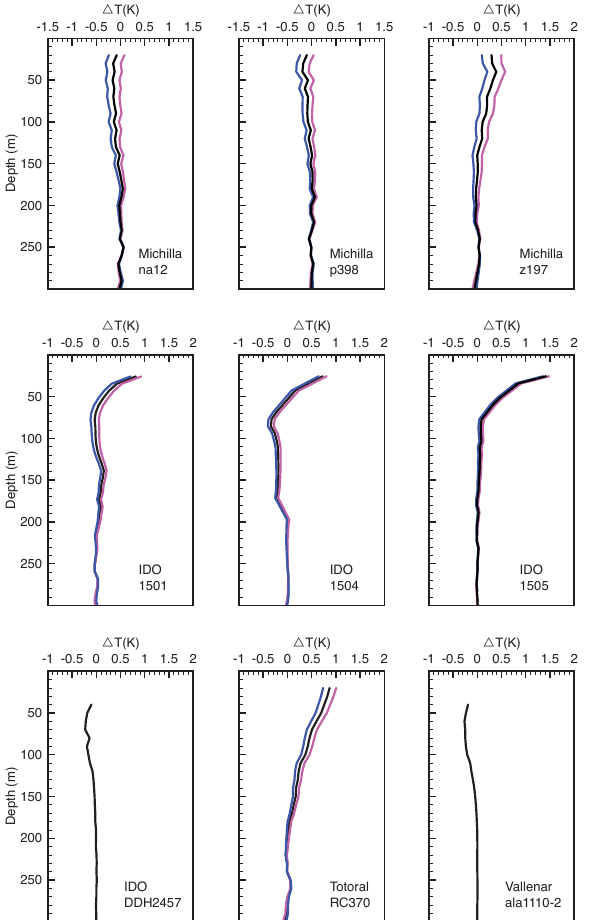
Figure 4. Temperature anomalies for the retained temperature– depth profiles, where IDO is Inca de Oro. The pink and blue lines represent the upper and lower bounds of the temperature anomaly. These are not visible at IDO-DDH2457 and Vallenar ala1110-2 be- cause they are superimposed.